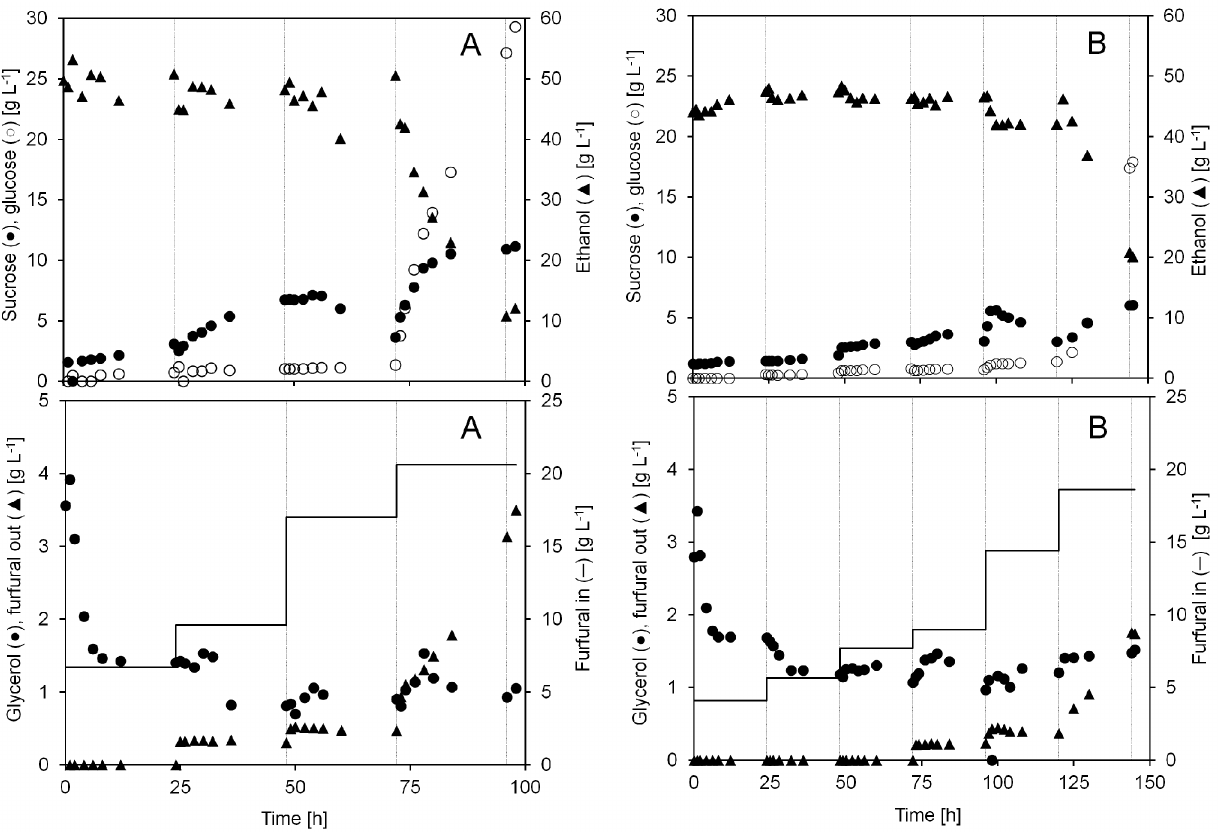
Figure 4. Concentrations of sucrose, glucose, ethanol, glycerol and furfural during two anaerobic continuous cultivations with continuous furfural addition (A and B). The furfural concentration (g L − 1 ) in the inlet medium and the permeate during each cultivation day is shown in the lower graphs. After each 24 h period, denoted by the gray gridlines in the graphs, the furfural concentration in the inlet medium was increased to the indicated